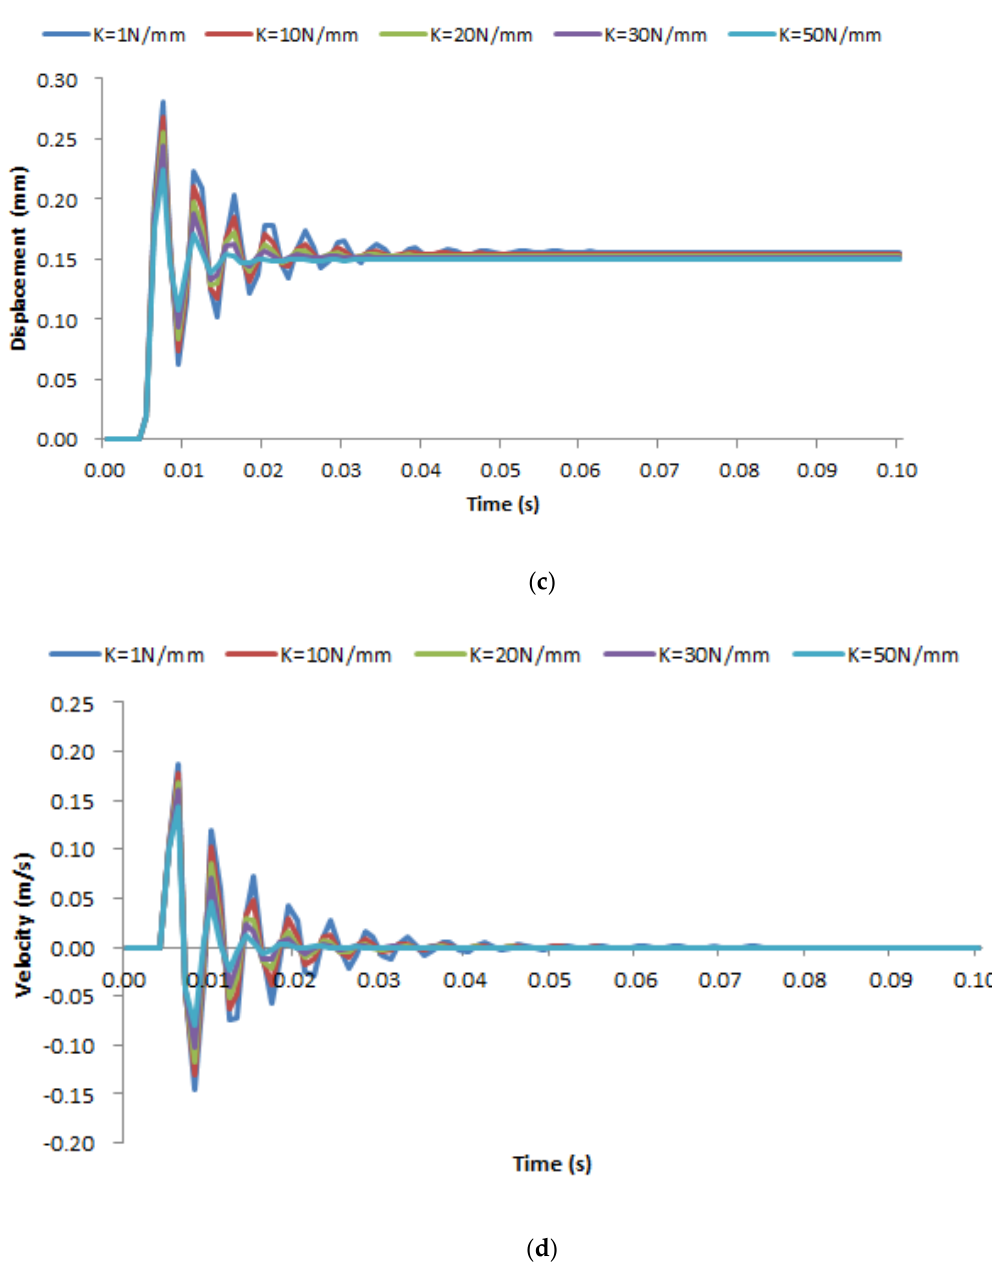
Figure 13. ( a ) The pressure response characteristics — spring stiffness: 1~50 N/mm. ( b ) The flowrate response characteristics — spring stiffness: 1~50 N/mm. ( c ) The displacement response characteristics — spring stiffness: 1~50 N/mm. ( d ) The velocity response characteristics — spring stiffness: 1~50 N/mm.